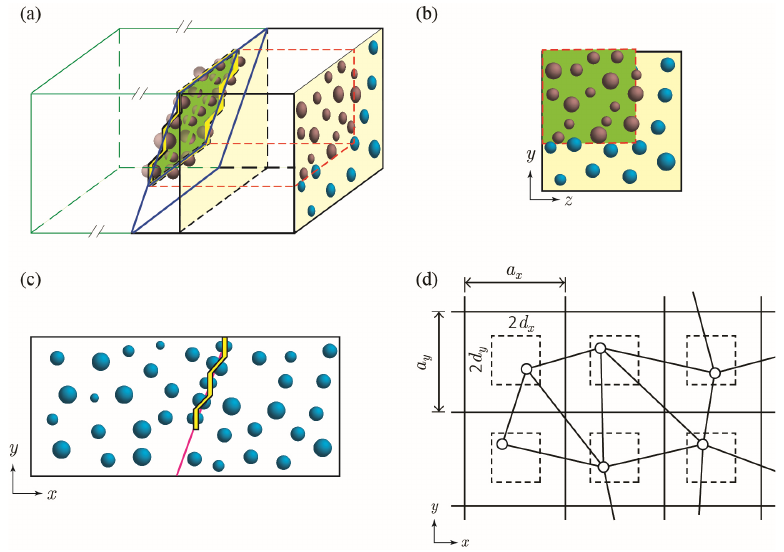
Figure 2. Three-dimensional (3D) visualization of cross section planes with respect to crack placement. ( a ) View of crack plane, ( b ) View of y – z plane with projection of crack; ( c ) View of x – y plane; ( d ) Schematic diagram of structured random distribution on x – y plane.